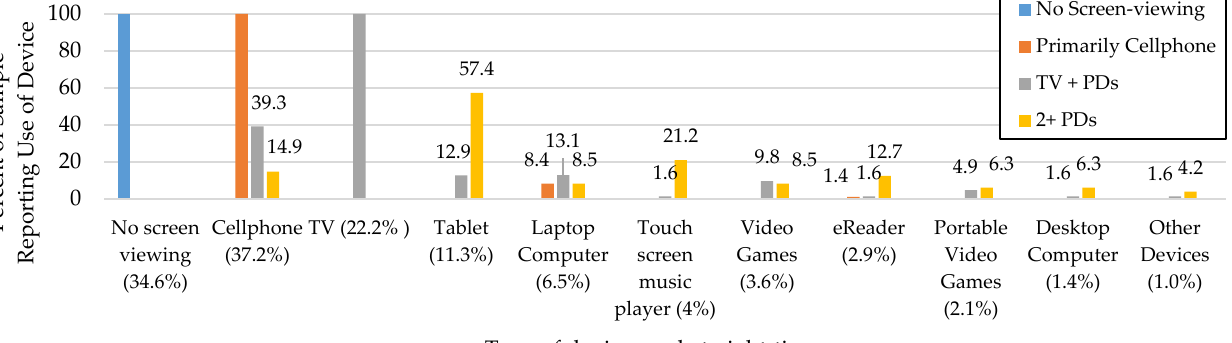
Figure 1. Night-time screen-viewing by cluster and device used Participants could select multiple devices unless they chose no screen-viewing; the proportion shown under each device indicates the amount of total sample using the device at night-time; TV = television; PD = portable device;